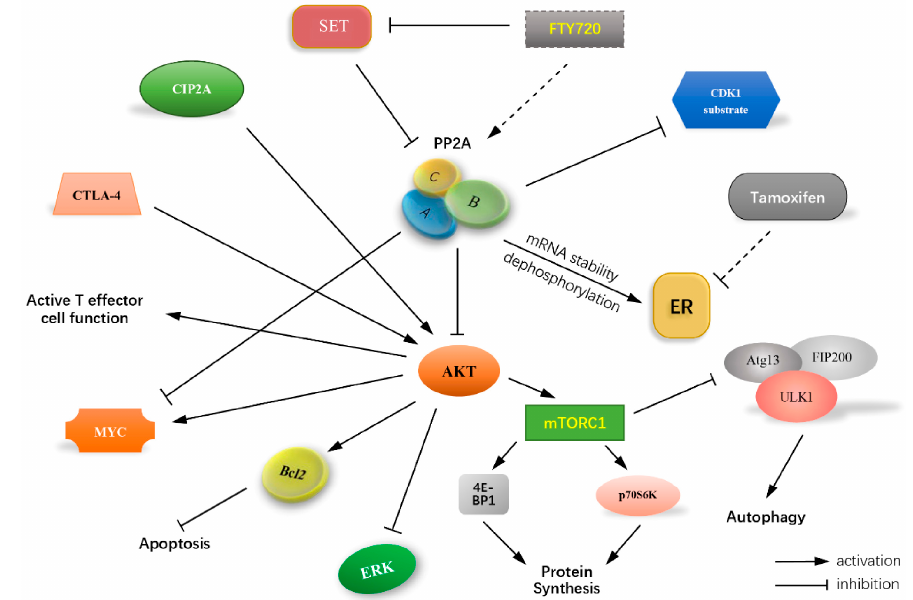
Figure 2. Role of PP2A regulating potential therapeutic targets for TNBCs. PP2A is widely involved in regulating most current developments in targeted therapeutic strategies for TNBCs, including cell cycle, DNA damage, EGFR degradation, immune responses, cell death resistance and ER or AR regulation. A better understanding of the structure of PP2A and its interactions with associated signaling pathways can give us a great appreciation of the crucial roles these phosphatases play in adapted therapeutic approaches for each type of TNBC and even resistance reversal as an importantly main node.